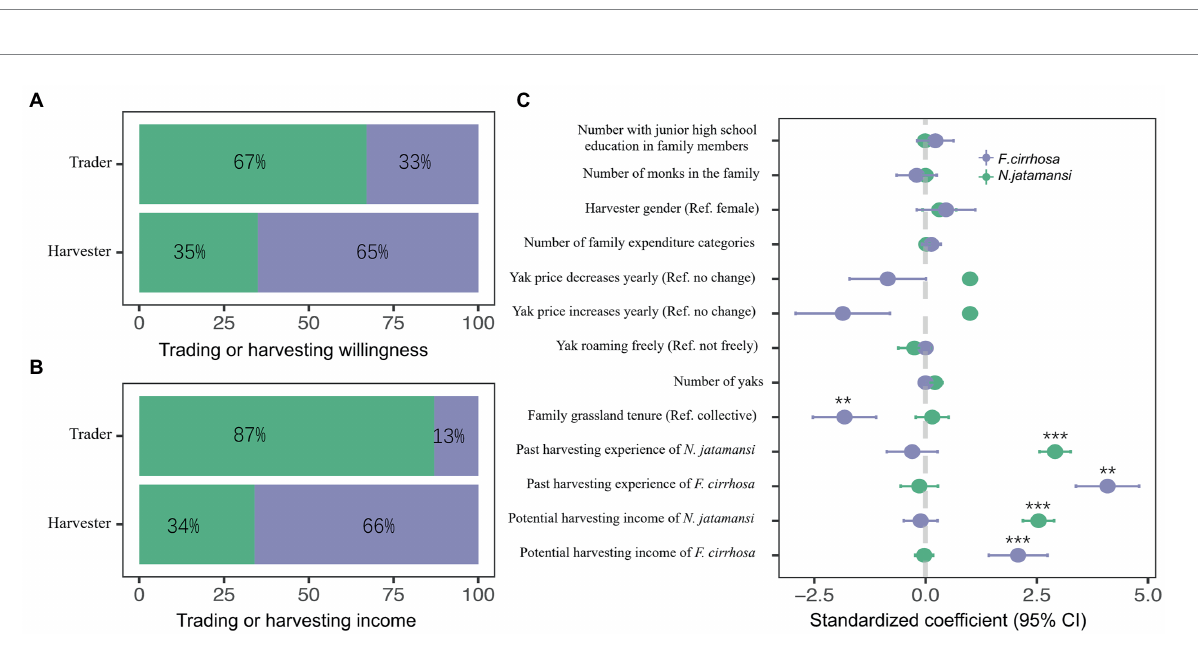
FIGURE 5 The proportion of harvester’s ( N = 923) and trader’s ( N = 20) willingness to harvesting and trading (A) and income (B) from harvesting or trading N. jatamansi or F. cirrhosa , and summary of GLMM estimate results and their standardized coefficients and 95% CI of harvesting willingness of N. jatamansi and F. cirrhosa ( N = 394) (C) . Purple color represents F. cirrhosa , green color represents N. jatamansi . Significance: *** p ≤ 0.001; ** p ≤